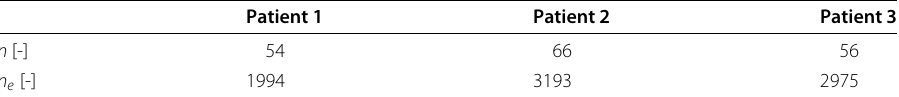
Fig. 10 Reduced meshes gained from ECSW. Only the colored mesh elements are evaluated and assembled in patient-specific DHROMs Table4 Number of degrees of freedom n and number of elements n e of constructed DHROMs Patient 1 Patient 2 Patient